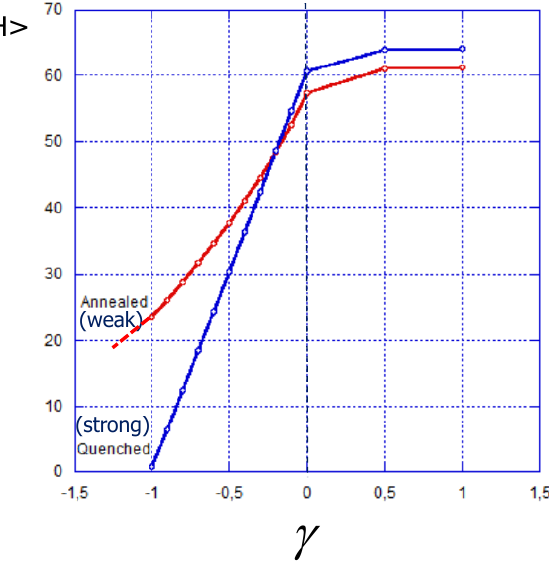
Figure 7. Average thickness (the first moment of the polymer density) in strong (blue curve) and weak (red curve) polyelectrolyte brushes as a function of reduced surface charge density γ . The average fraction of charged monomer units in strong and weak polyelectrolyte brushes at zero surface charge is the same and corresponds to α = (cid:104) α (cid:105) = 0.5. Other parameters: N = 300, a 2 / s = 0.001, salt concentration c s a 3 = 10 − 5